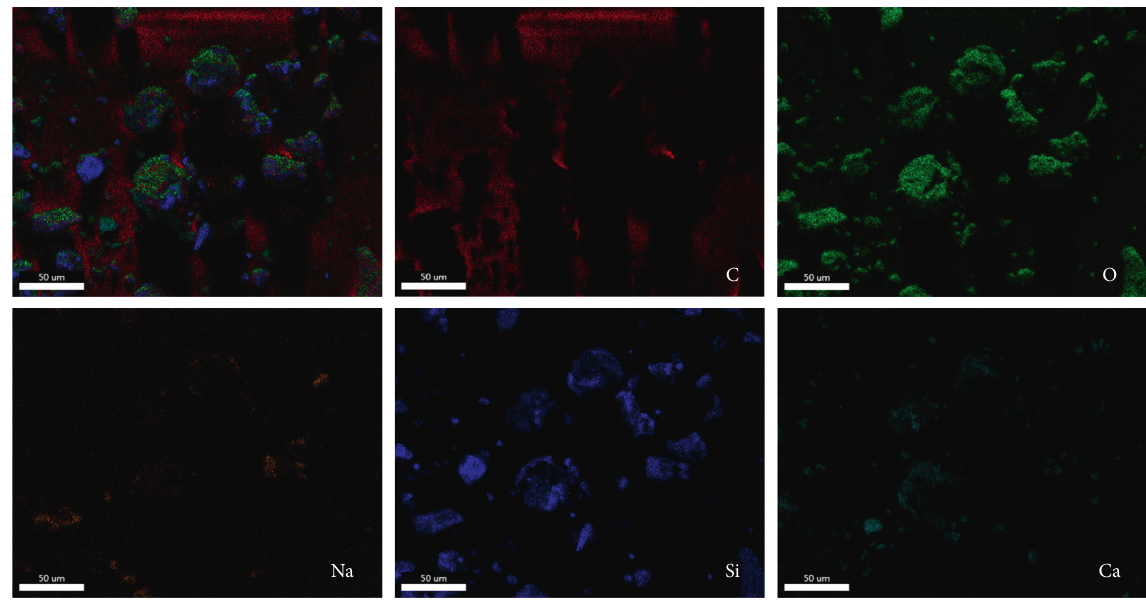
Figure 5: Element mapping of a paleosol sample using Table 4: Percentage of elements in the paleosol.